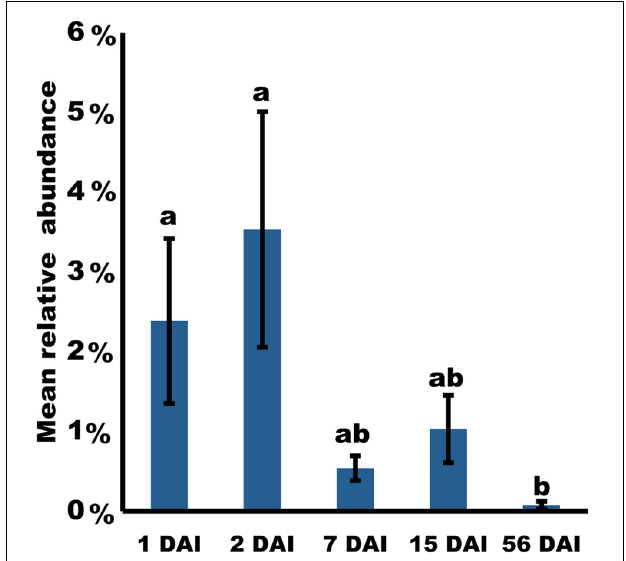
FIGURE 3 | Time-course changes in relative abundance of Pseudomonas simiae PICF7 (ASV024) in banana roots during an interval of 56 days based on 16S rRNA gene amplicon sequence. P -values were calculated using likelihood ratio test. Different letters indicate significant differences ( p < 0.05). Error bars indicate standard deviations ( n =